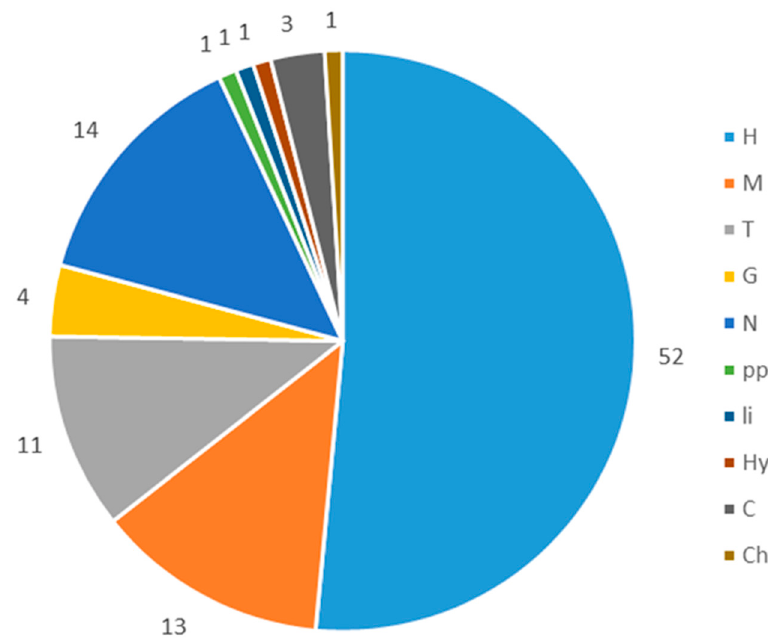
Figure 3. Percentage share of plant life forms in the Niwka postmining area: (H) hemicryptophyte; (M) megaphanerophyte, (N) nanophanerophyte, (T) therophyte; (G) geophytes; (Ch) chamaephytes; (Hy) hydrophytes; (C) herbaceous chamaephyte, (li) liana, and (pp) semiparasite.